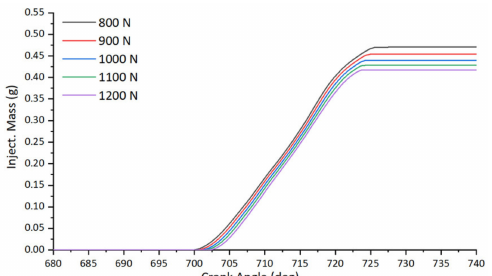
Figure 16. Cumulative fuel injection mass per cycle under varied needle valve opening pressures.